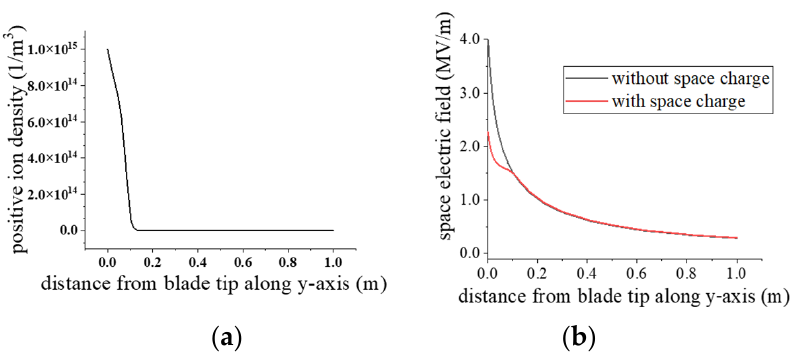
Figure 6 . Distortionary effect of space charge on the electric field near the blade tip: ( a ) positive ions density, ( b ) electric field near static blade tip.